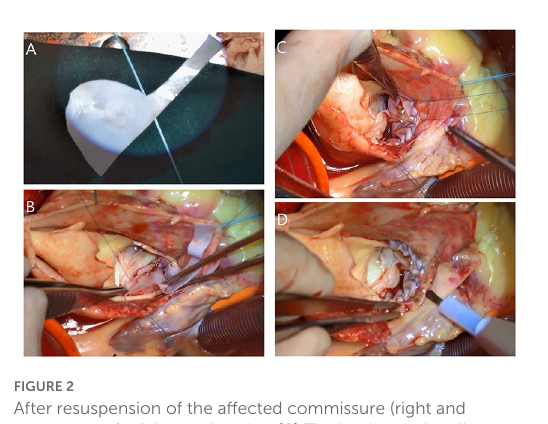
FIGURE2 After resuspension of the affected commissure (right and noncoronary) of the aortic valve. (A) The bovine pericardium patch was created for the non-coronary sinus and sinotubular junction of the right sinus was placed internally. (B) The 5-0 polypropylene continuous sutures were applied around the edge of the non-coronary sinus and (C) around the sinotubular junction of the right sinus. (D) The reconstructed aortic